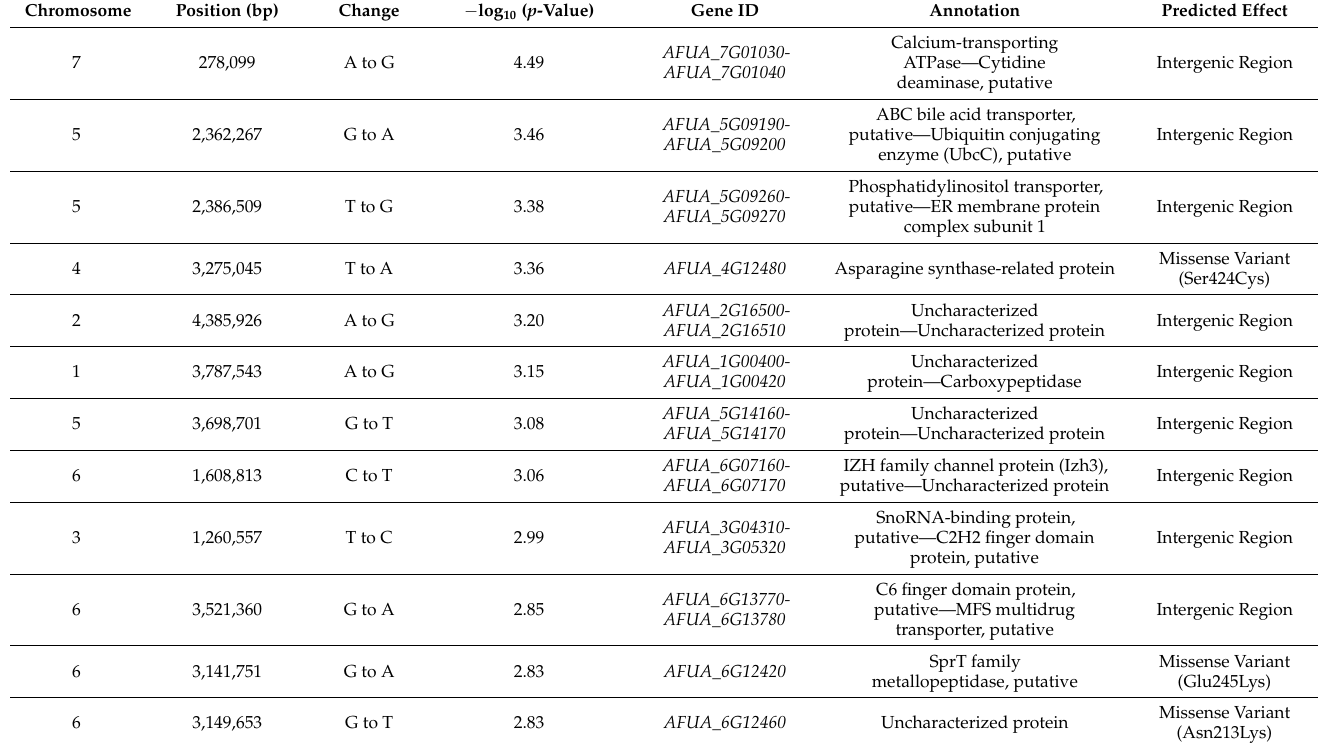
Table 2. The top 20 SNPs associated with AMB susceptibility, arranged based on − log 10 ( p